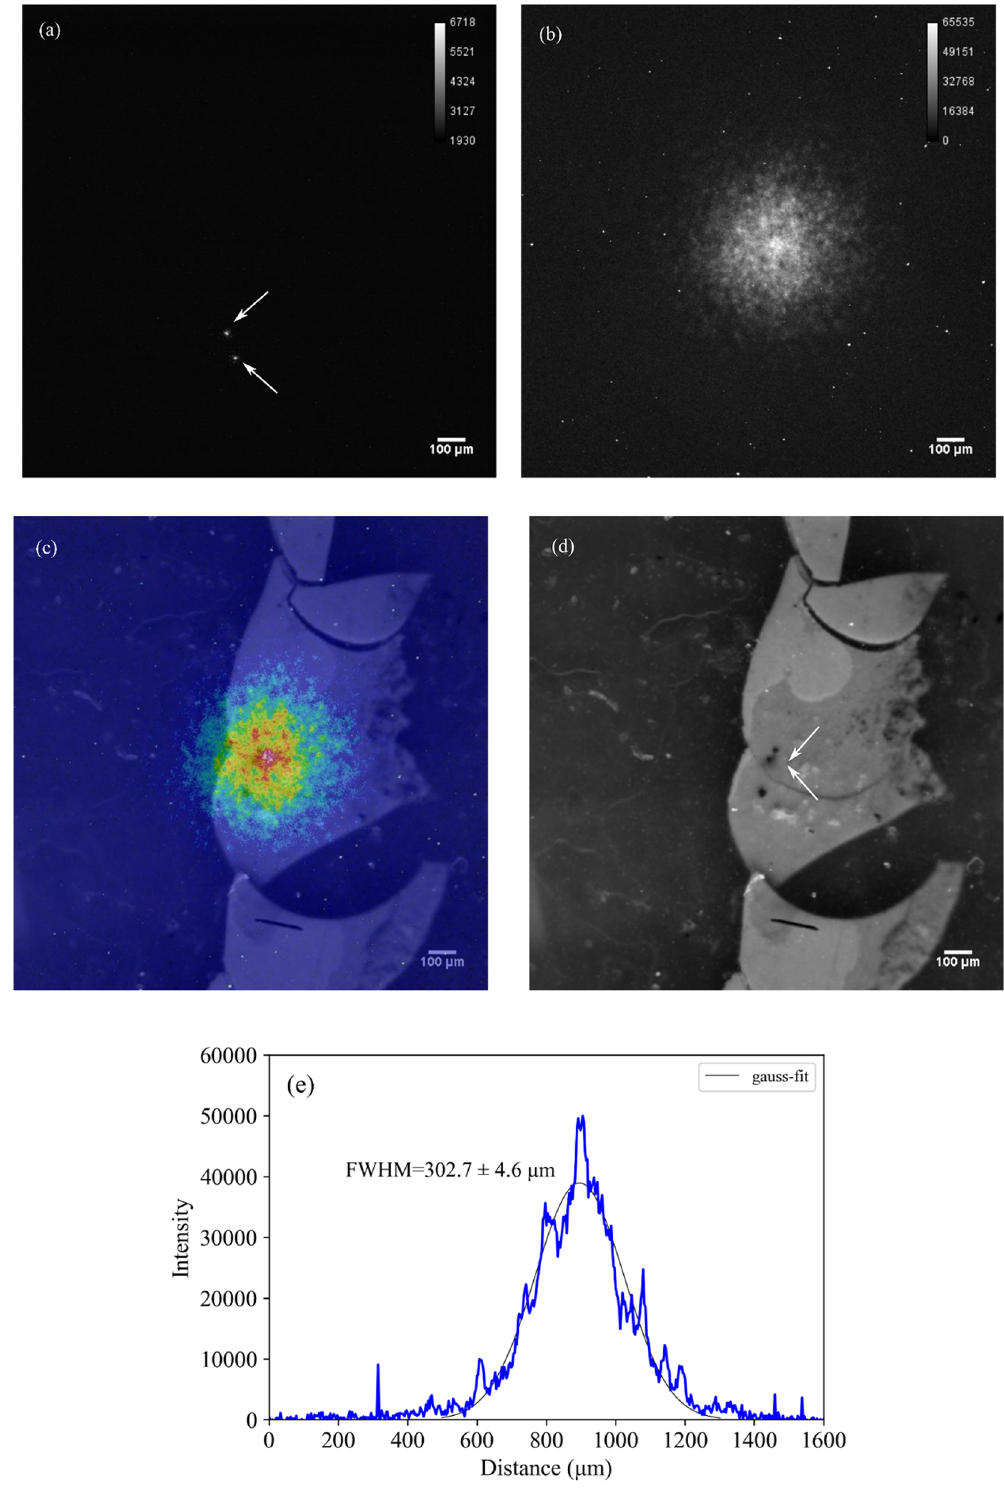
Figure 5. Alpha particles emitted from a plutonium particle with a zoom range of 5 × using ( a ) the 50-ms, ( b ) 30-min acquisitions, ( c ) superimposition of the optical image and alpha particle image, ( d ) the optical image, and ( e ) intensity profile of the alpha particle emitted from a plutonium particle. The arrows in ( a ) show the individual alpha particle locations. The arrows in ( d ) show the PuO 2 particle location. The images of using the “Sequence mode” with 50-ms intervals can be found as Supplementary Fig. S3